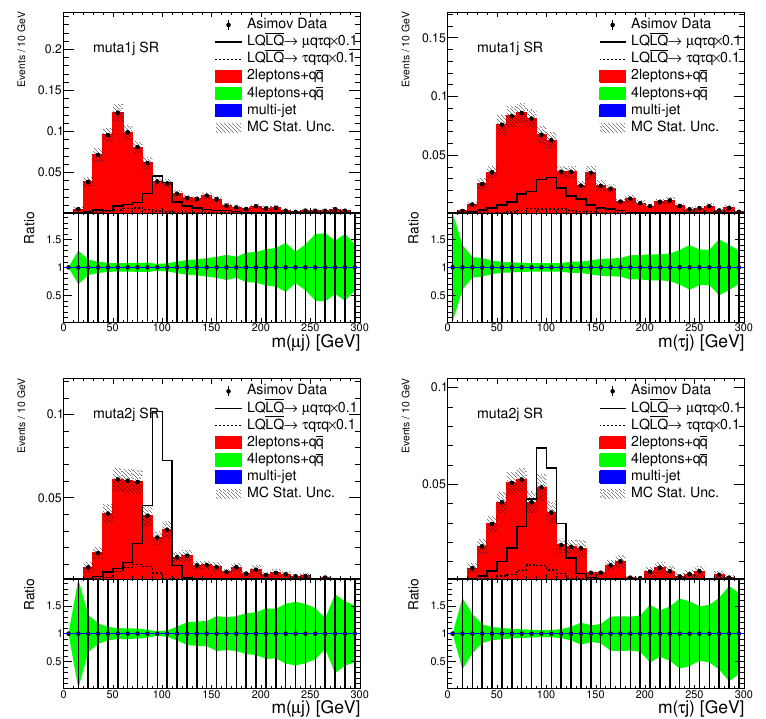
Figure 6 . The distribution of the invariant mass of a lepton candidate and a jet candidate in the signal region “muta1j” (top) and “muta2j” (bottom). The left one is m ( µj ) and the right one is m ( τj ) . The black points in the upper pads show the asimov data which is just the sum of all background events with uncertainties completely suppressed for better illustration. The ratio of the asimov data and the total background is shown in the lower pads, where the error bars on the black points represent the expected data uncertainty while the green bands represent the total MC statistical uncertainty.